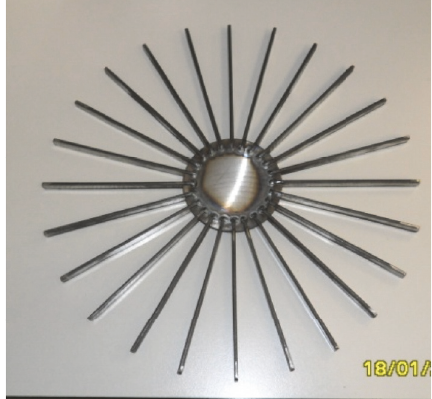
Figure 1: Test rotor with 24 blades.